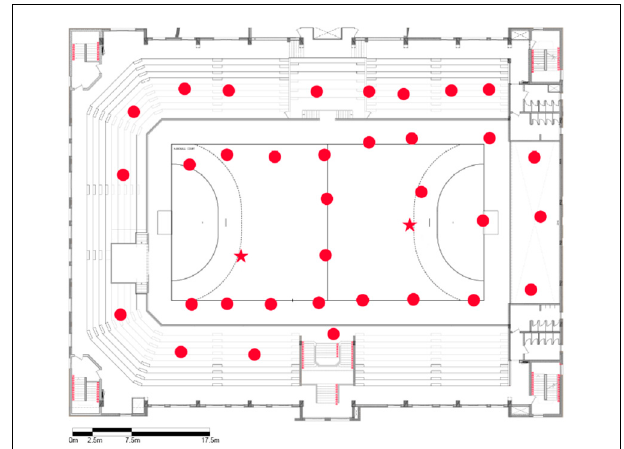
Figure 3. Layout of the indoor sport hall (Q); the average height was 10.2 m; the volume was 25,792.0 m 3 ; red circles represent the location of measurement points of reverberation time; red stars represent the locations of sound source (omnidirectional loudspeaker).